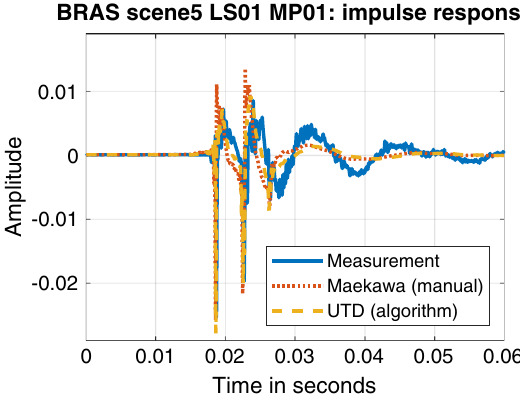
Figure 14. Selection of loudspeaker transfer functions required for the calculation of BRAS scene 5 (LS01, MP01) [46].